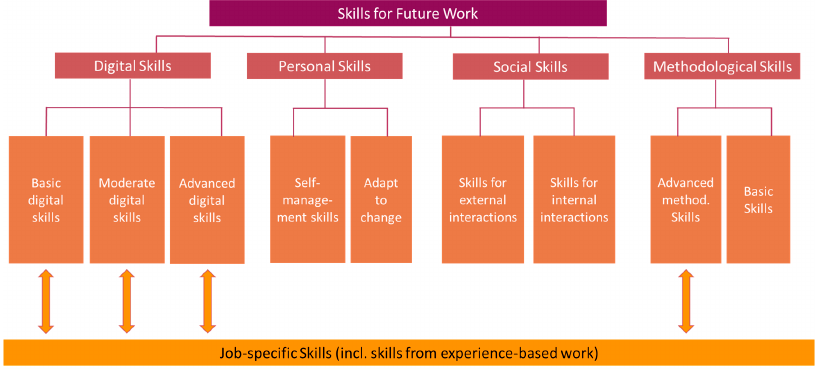
Figure 1. Beyond 4.0 Skills Classification. Source: [34] (p. 9).